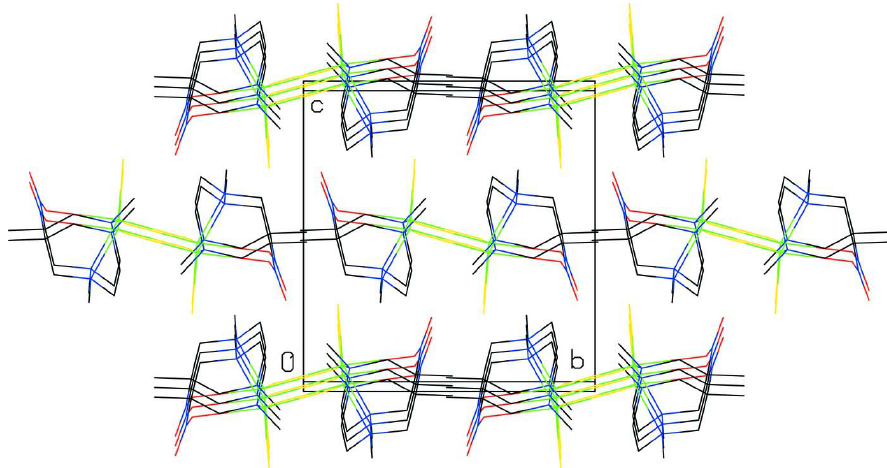
Figure 2 View down the a axis of the packing of copper complex. Di- µ